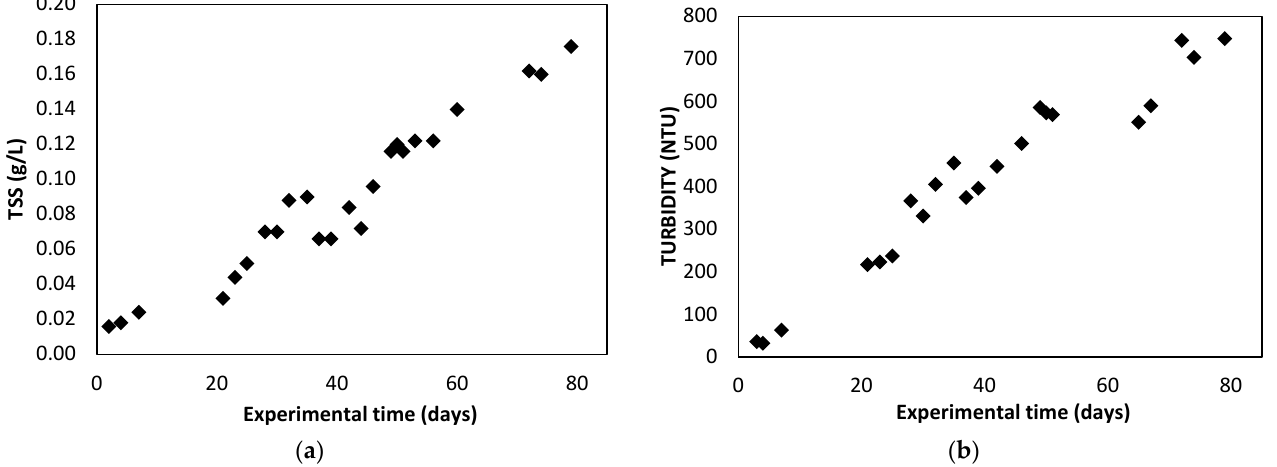
Figure 2. Evolution of TSS ( a ) and turbidity ( b ) in the photobioreactor during the experimental period.